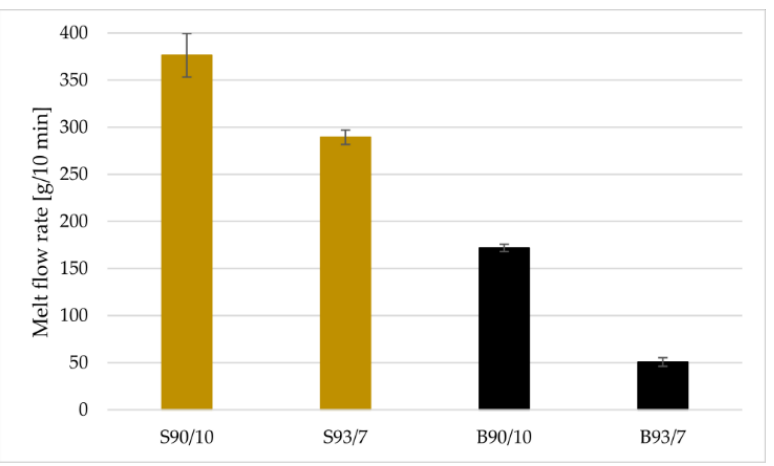
Figure 6 . The melt flow rate [g/10 min] of Mqp S and Mqp B+ filaments with various filler loadings.